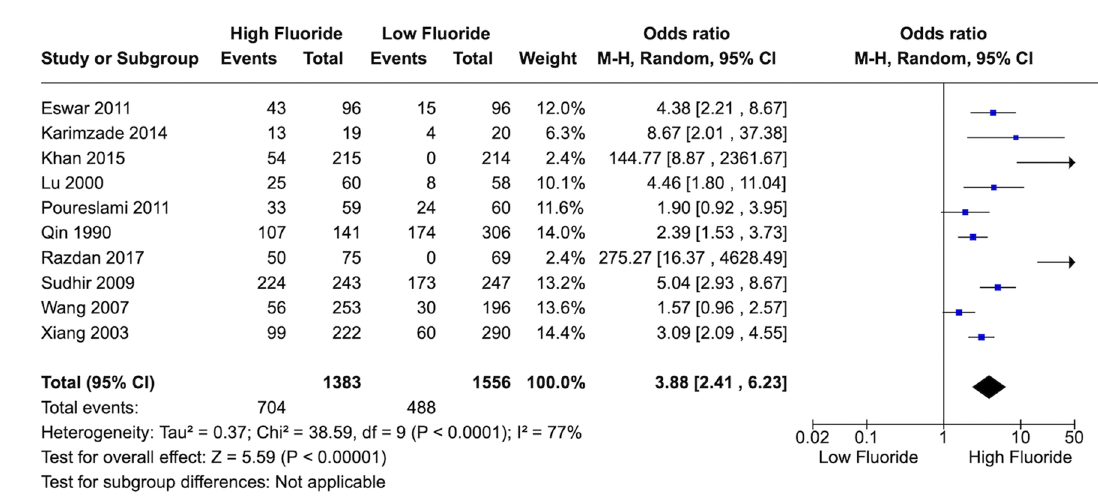
Figure 2. Forest plot of meta-analysis for ten studies (I 2 = 77%). The association between chronic exposure to fluoride and cognitive deficit. CI, confidence interval; M-H, Mantel–Haenszel method. The figure was created using Review Manager v. 5.3 software (https:// train ing. cochr ane.